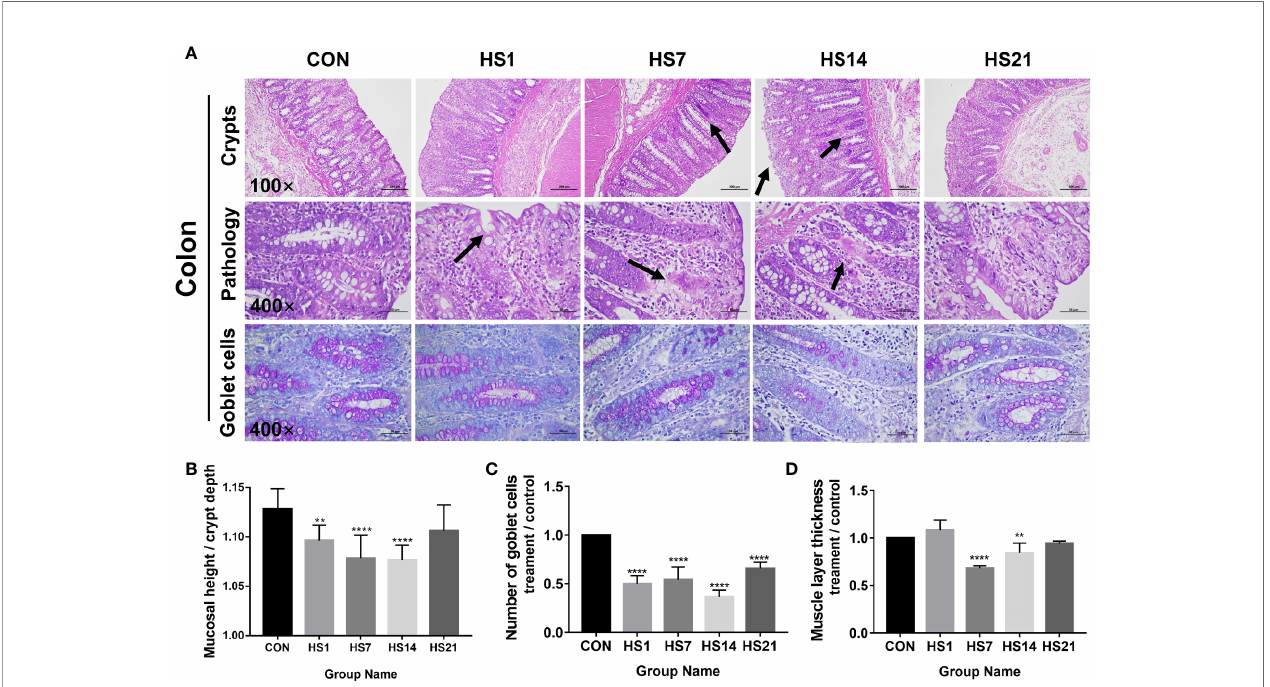
FIGURE 4 | Effect of HS on the morphology structure of colon. CON indicates no heat stress group, HS1, 7, 14, 21 indicate heat stress day 1, 7, 14, and 21 groups respectively, n = 6; “ ** ” indicates p < 0.01, “ **** ” means p < 0.0001. (A) HE and PAS staining results of paraf fi n sections of colon; (B) villus height/crypt depth; (C) PAS positive cell number; (D) intestinal muscle layer thickness. As the arrows showing, after HS treatment, the colonic mucosal were loosely arranged and showed signs of bleeding on days 1, 7 and 14 of HS, the local injury and lymphatic in fi ltration also had been found on days 7 and 14 of